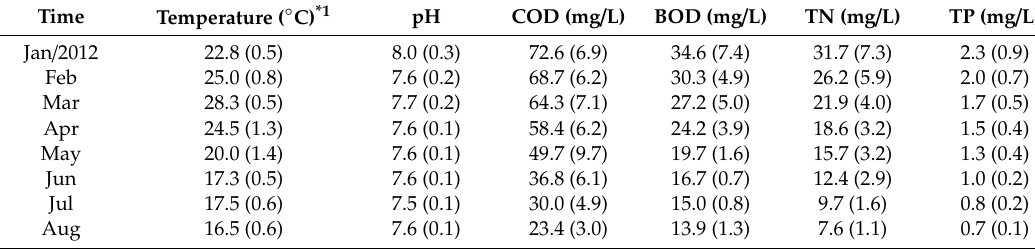
Table 4. Mean and standard deviation on indicators of water quality treated by bio-fence. Chemical oxygen demand (COD); biological oxygen demand (BOD); total nitrogen (TN), and total phosphate (TP). Time Temperature ( ◦ C) *1 pH Jan /